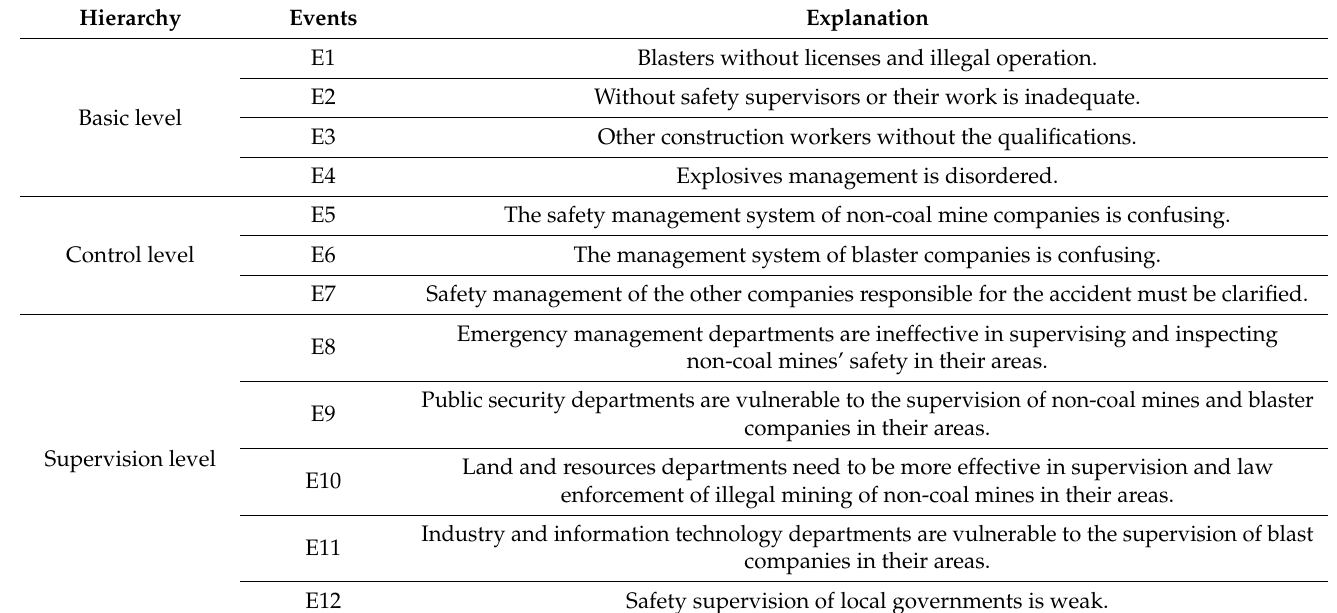
Table 2. Set of non-coal mine explosion